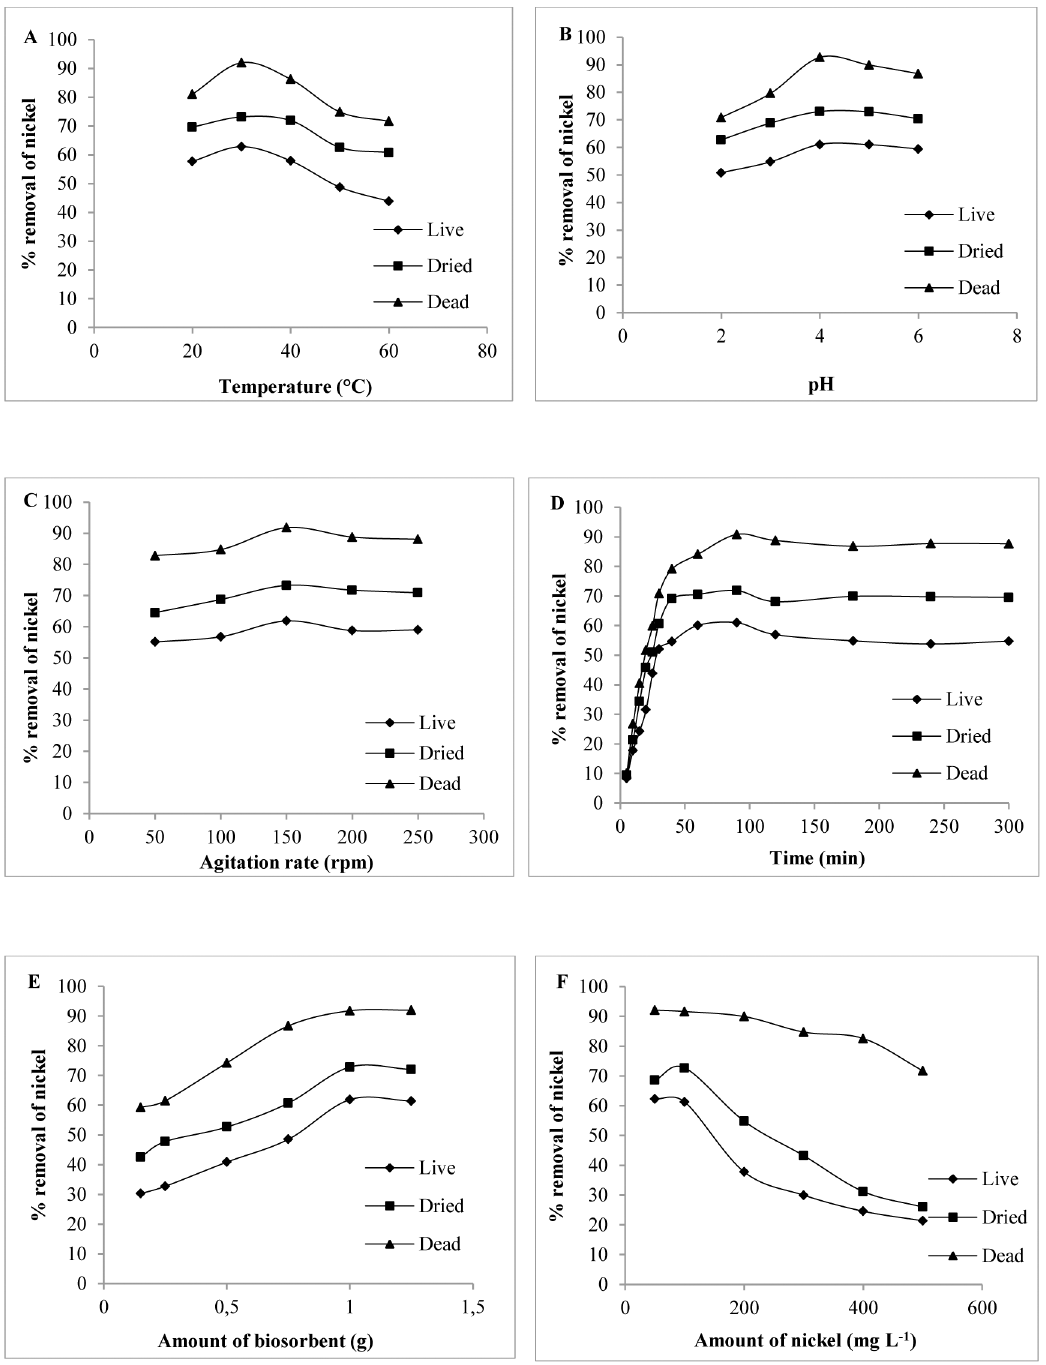
Fig 1. Biosorption studies. Biosorption properties of the three types of H . lixii biomass. (A) Effect of temperature. (B) Effect of pH. (C) Effect of agitation rate. (D) Effect of contact time. (E) Effect of the amount of biosorbent. (F) Effect of initial nickel concentration.